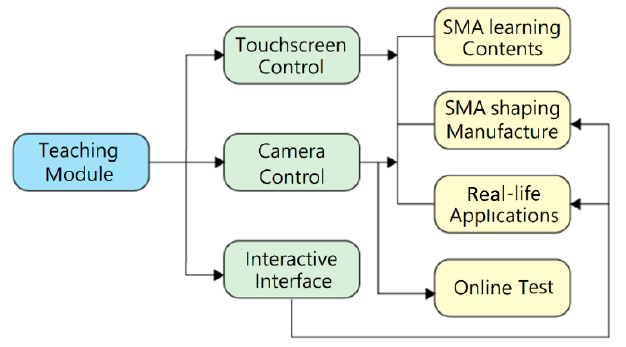
Figure 6. System architecture of the SMA teaching module.